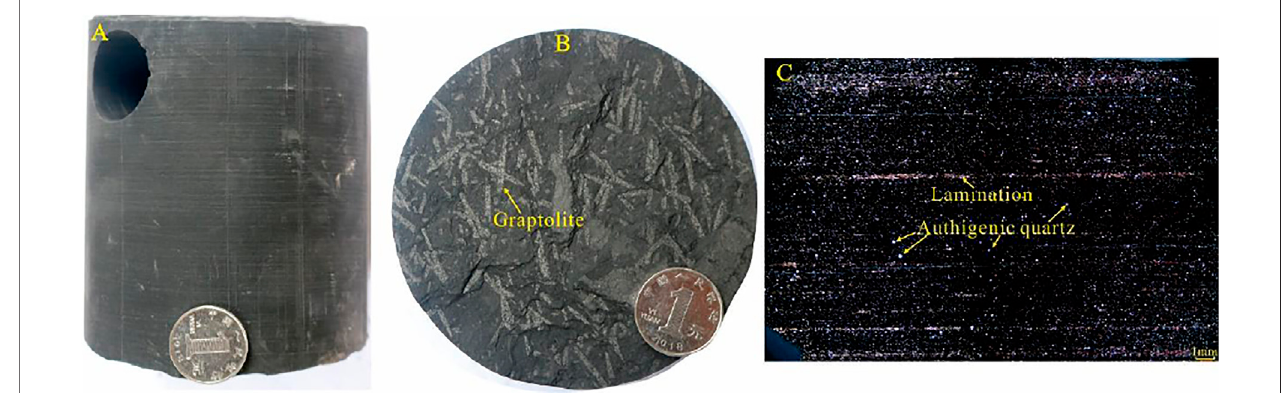
FIGURE 3 | Core photographs and thin-section photomicrograph showing characteristics of siliceous shale. (A) Core photograph showing lamination well- developed,2,509.24 – 2,509.40m,wellN15. (B) Corephotographshowingabundantgraptoliteswitharandomarrangement,2,509.49 – 2,509.63m,wellN15. (C) Thin- section photomicrograph showing horizontal quartz lamination and abundant authigenic quartz particles developed, 2,507.09 m, well N15.